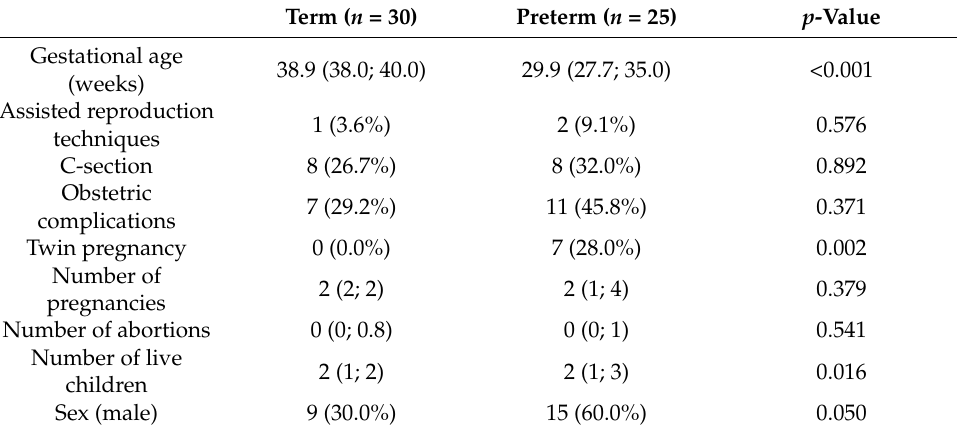
Table 2. Clinical characteristics between women with term and preterm